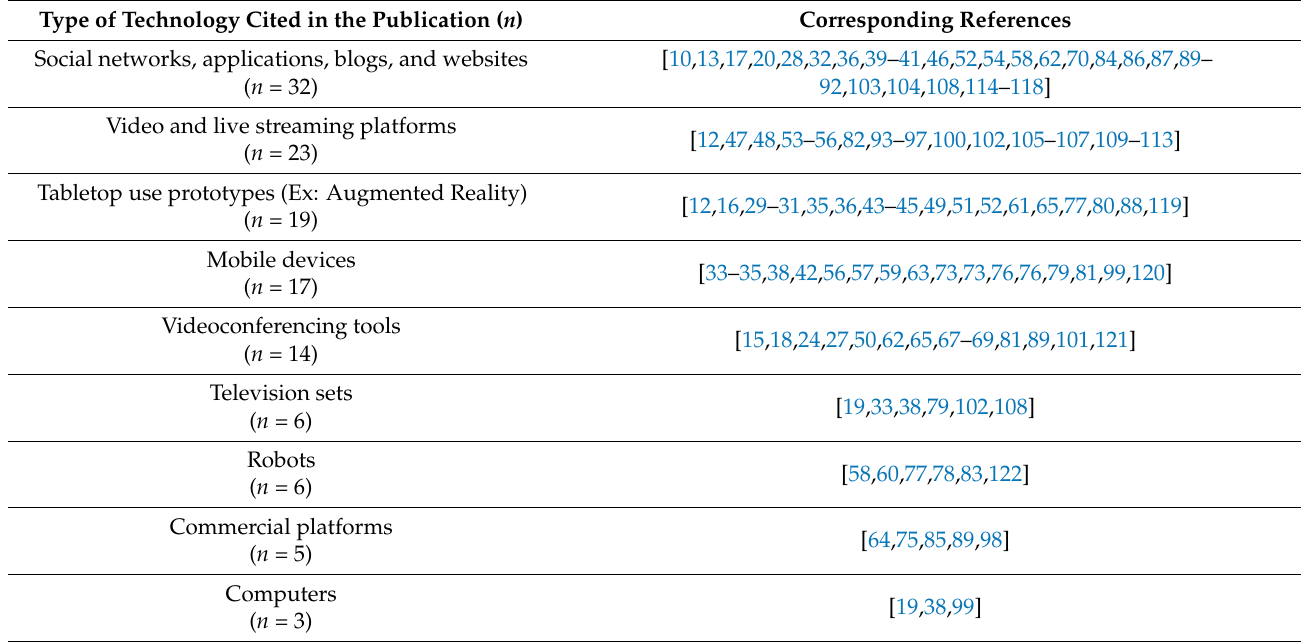
Table 2. Types of technologies cited in the selected publications.